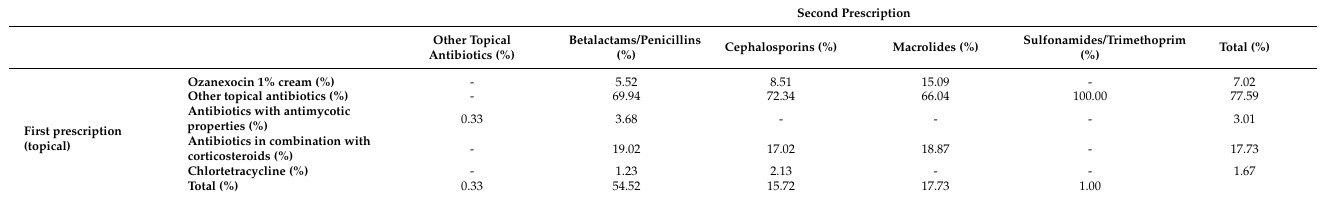
Table 4. Combination of topical and systemic therapies prescribed among treatment failure. Pedianet,